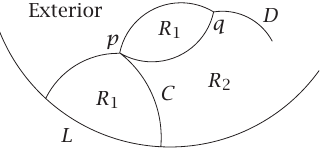
Figure 6.7 . After rolling the toroidal component of R 1 along the spherical surface corresponding to D , we obtain an illegal singularity. (Note that dou- ble bubble does not remain a surface of revolution after rolling, and that this figure is not the generating curve after rolling, but rather is the hemisphere slice where contact happens.)